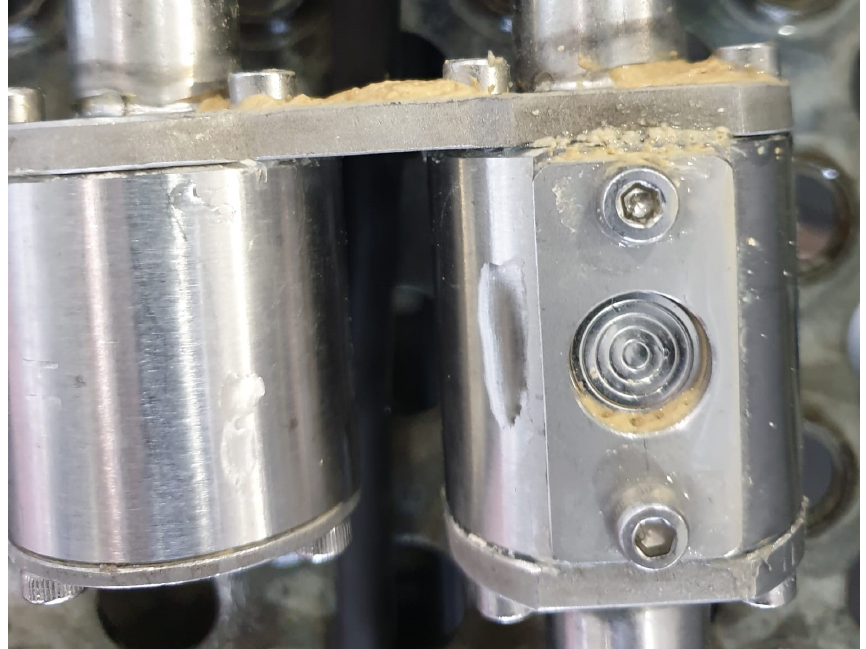
Figure 10. Residue build-up